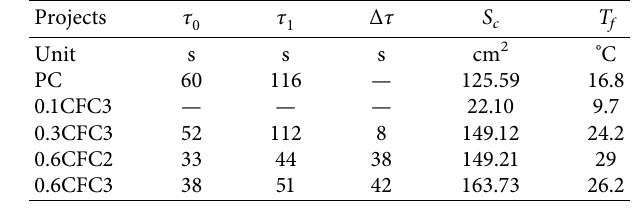
Table 5: Deicing area at different dosing levels. Table 6: Comparison of microwave deicing efficiency with dif- ferent carbon fiber doping and